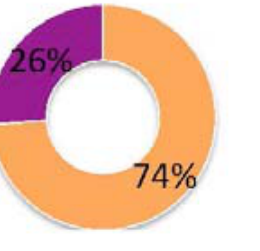
Figure 2: Direction of Strabismus Only one subject (2.7%) presented with a vertical deviation (a hypertropia in addition to the